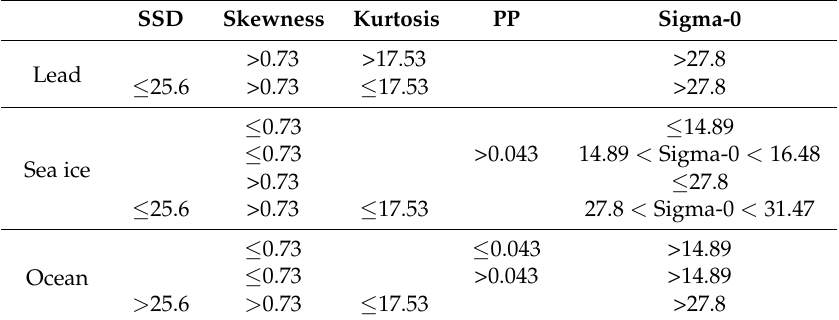
Table 6. An example of threshold-based rules produced by See 5.0 using IC to classify leads, sea ice and